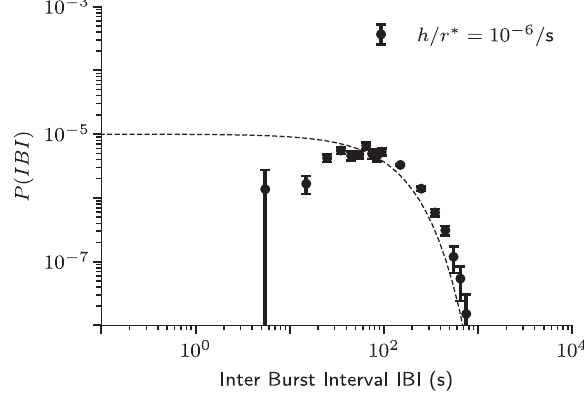
8. Inter-burst-interval (IBI) distribution for annealed- average networks averaged over 12 independent simulations. Intervals are measured as times between proper burst onsets ( a t > 20 r (cid:2) ). Dashed lines show the exponential inter-spike- interval distribution of the Poisson external